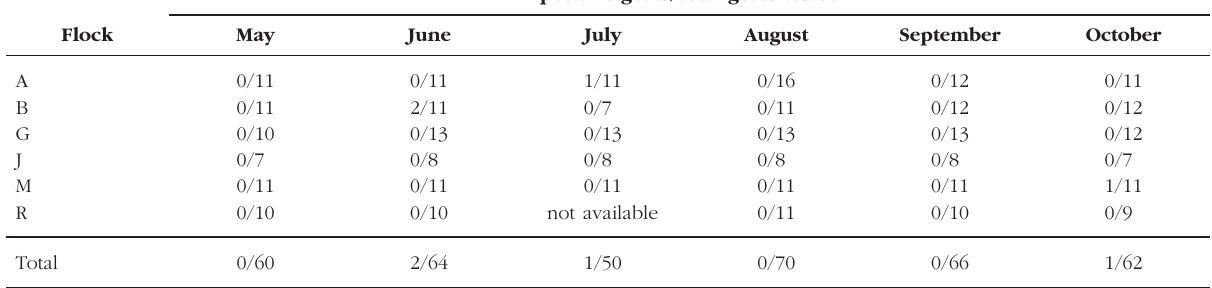
Table I. – EDTA-blood samples of goats from Central Switzerland, 2008, positive for Anaplasma phagocytophilum in real-time PCR ( msp2